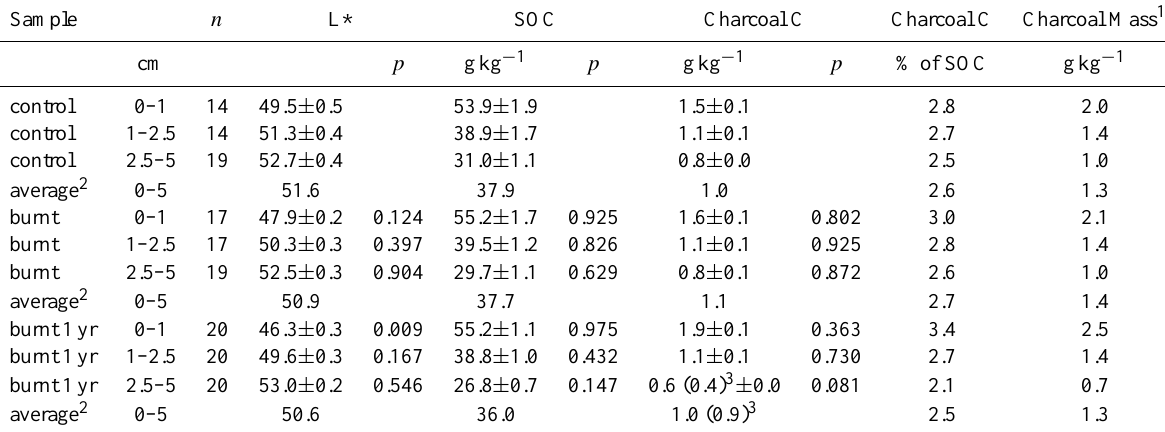
Table 2. Means and standard errors for soil samples taken before the burning (control), immediately after the burning (burnt) and one year after the burning (burnt 1yr). The values are given for the three depths and the weighted average.